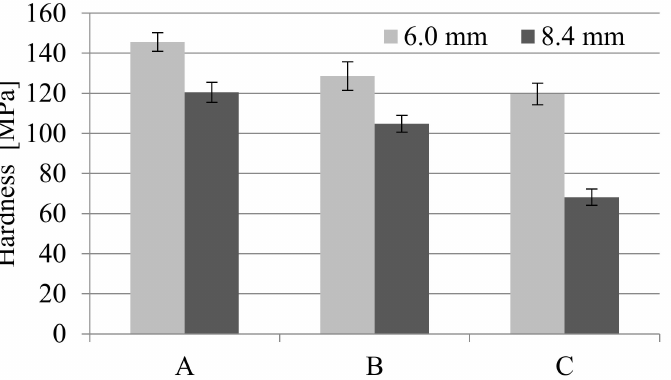
Figure 23. Influence of MuCell ® parameters and moldings thickness on the hardness, where A is a solid sample, while B and C are foamed at 16 and 20 MPa nitrogen pressure respectively.